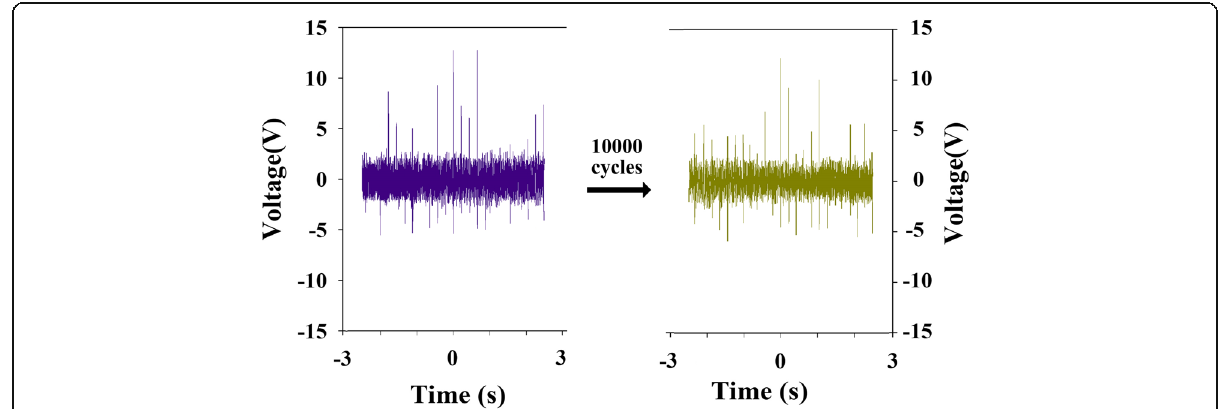
Fig. 4 Vertical force test of fabricated S-TENG. The output voltage decreases only slightly under a loading resistance of 100 M